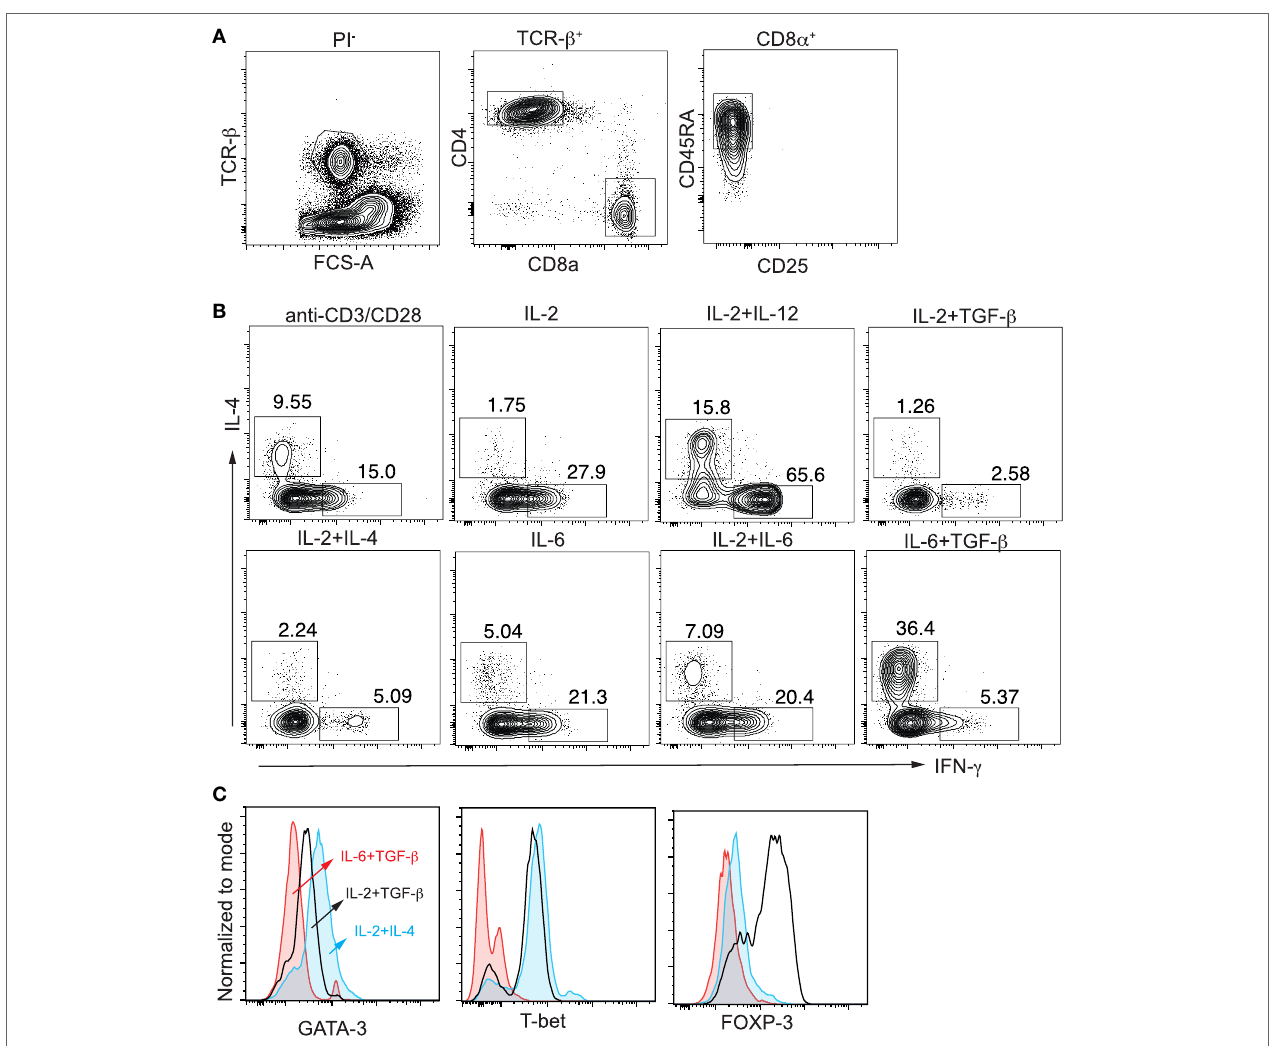
FigUre 1 | Differentiation of naïve cord blood CD8 + T cells. (a) Flow sorting of naïve CD8 + T cells from thawed cord blood mononuclear cells; (B) intracellular expression of IFN- γ and IL-4 after activation of naïve CD8 + T cells with anti-CD3/CD28 microbeads (1:1) ± cytokines; (c) decreased expression of GATA-3 and T-bet after induction of IL-4 expression by IL-6 + TGF- β in CD8 + T cells compared with cells activated by IL-2 + IL-4 and IL-2 + TGF- β . Data are representative of n > 10 donors, all showing similar